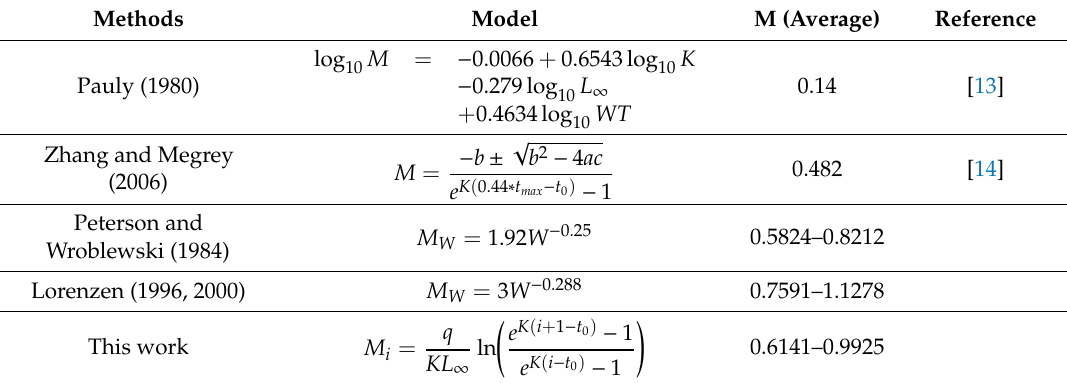
Table 2. Comparison of the estimates of natural mortality of sandfish based on their fecundity, growth rate, and catch data using the various